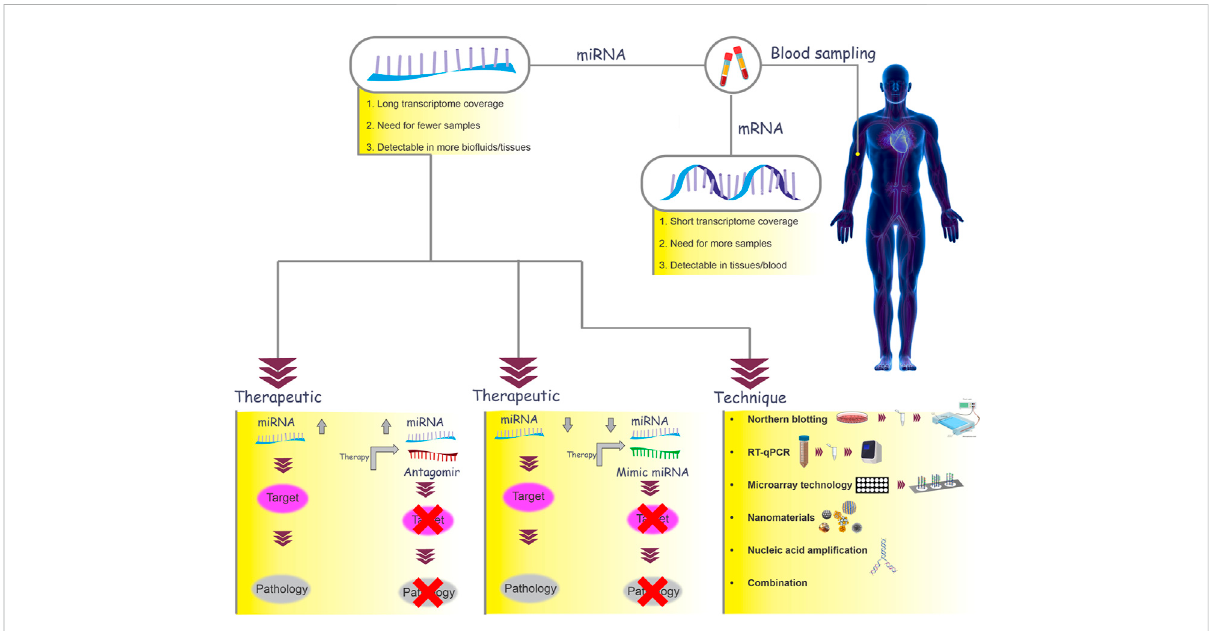
FIGURE 3 MiRNAs as biomarkers. In this graph, mRNAs and miRNAs are compared as two biomarker candidates. MiRNAs can be used as therapeutic targets inanumber ofways. Depending on whether themiRNA is upregulated or downregulated in thedisease, there are generallytwo approaches: miRNA inhibition and miRNA replacement. If an increase in the miRNA expression leads to pathology (e.g., RIF), the use of miRNA antagomirs in therapeutic methodswill preventthebindingof miRNAs to thetarget mRNA and willreduce thesymptoms ofthedisease. Ontheotherhand, if areductioninmiRNAexpressionleadstopathology,amiRNAdeliverysystem(miRNAmimic)canbeused.Thereareseveraltechniquesfordetecting miRNAs (northern blotting, reverse transcription quantitative real-time PCR (RT-qPCR), microarray technology, nanomaterial-based methods, and nucleic acid ampli fi